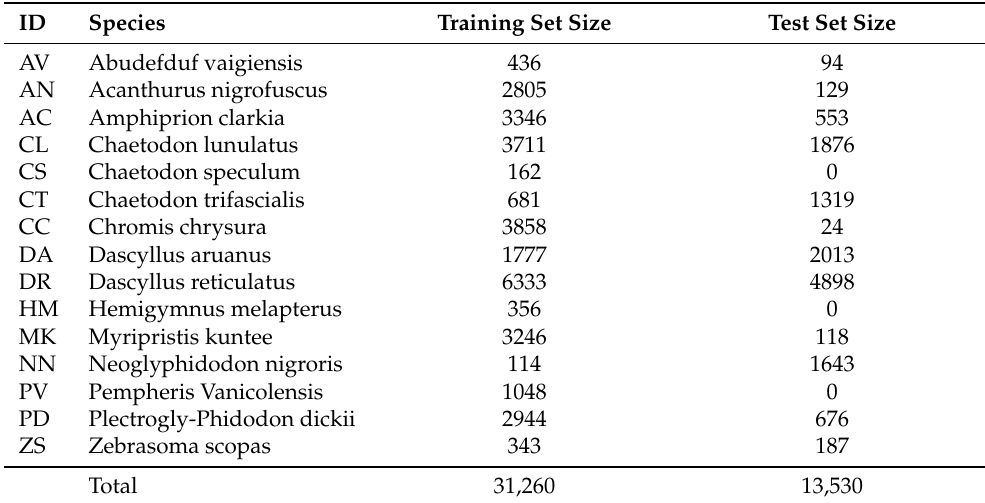
Figure 3. Sample images of 15 fish species in LCF-2015 dataset. Table 1. The fish species distribution in LCF-15